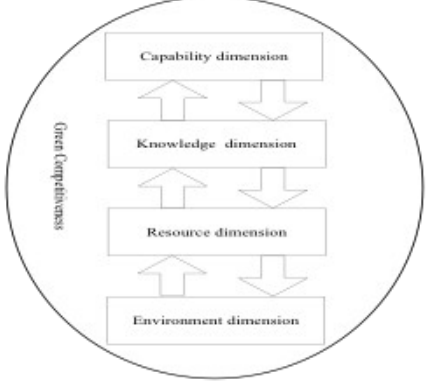
Figure 1. The interrelations among the four